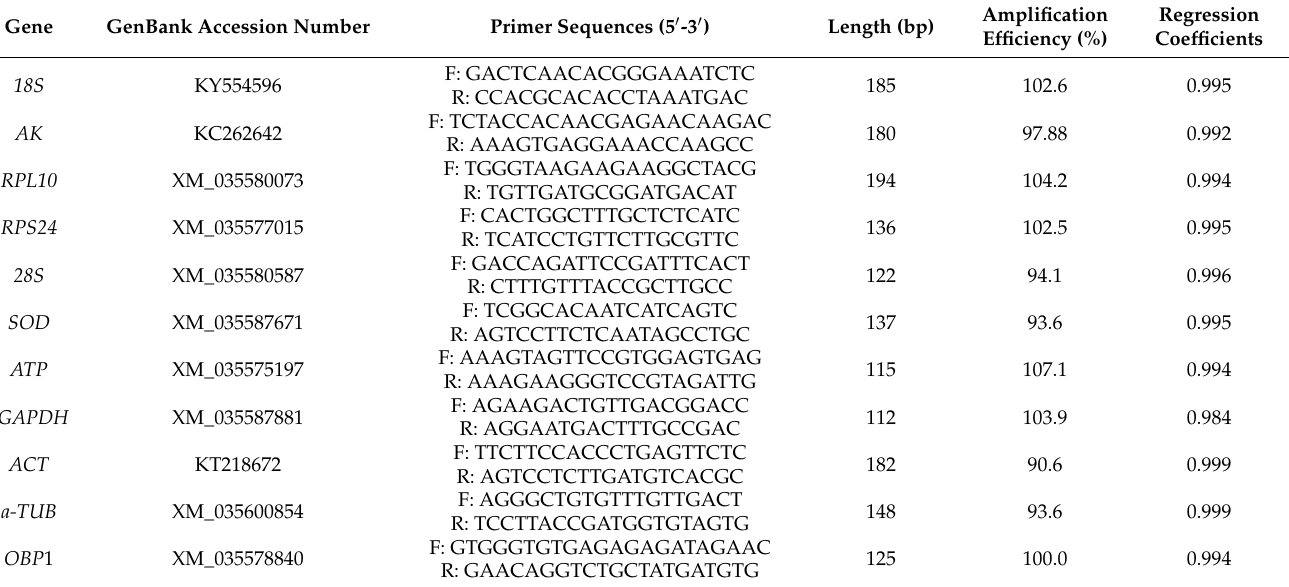
Table 1. Primers used for qRT-PCR in S. frugiperda . Primer Sequences (5 (cid:48) -3 (cid:48)